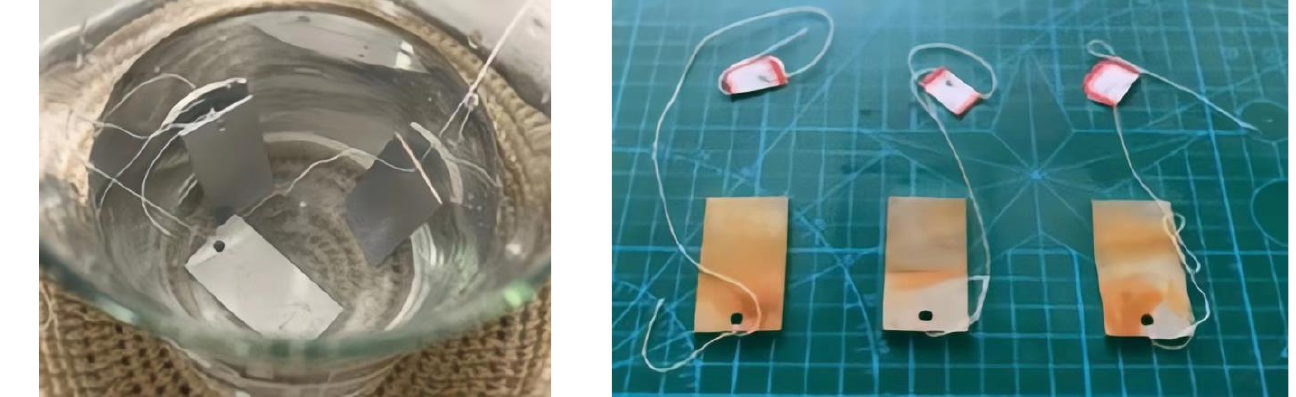
Figure 6. Metal corrosion diagram.